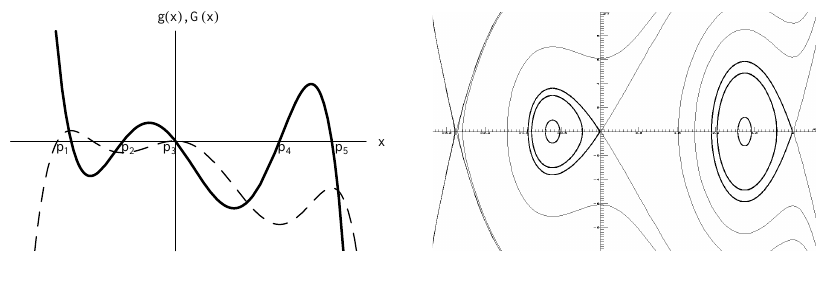
Figure 6. The phase plane.